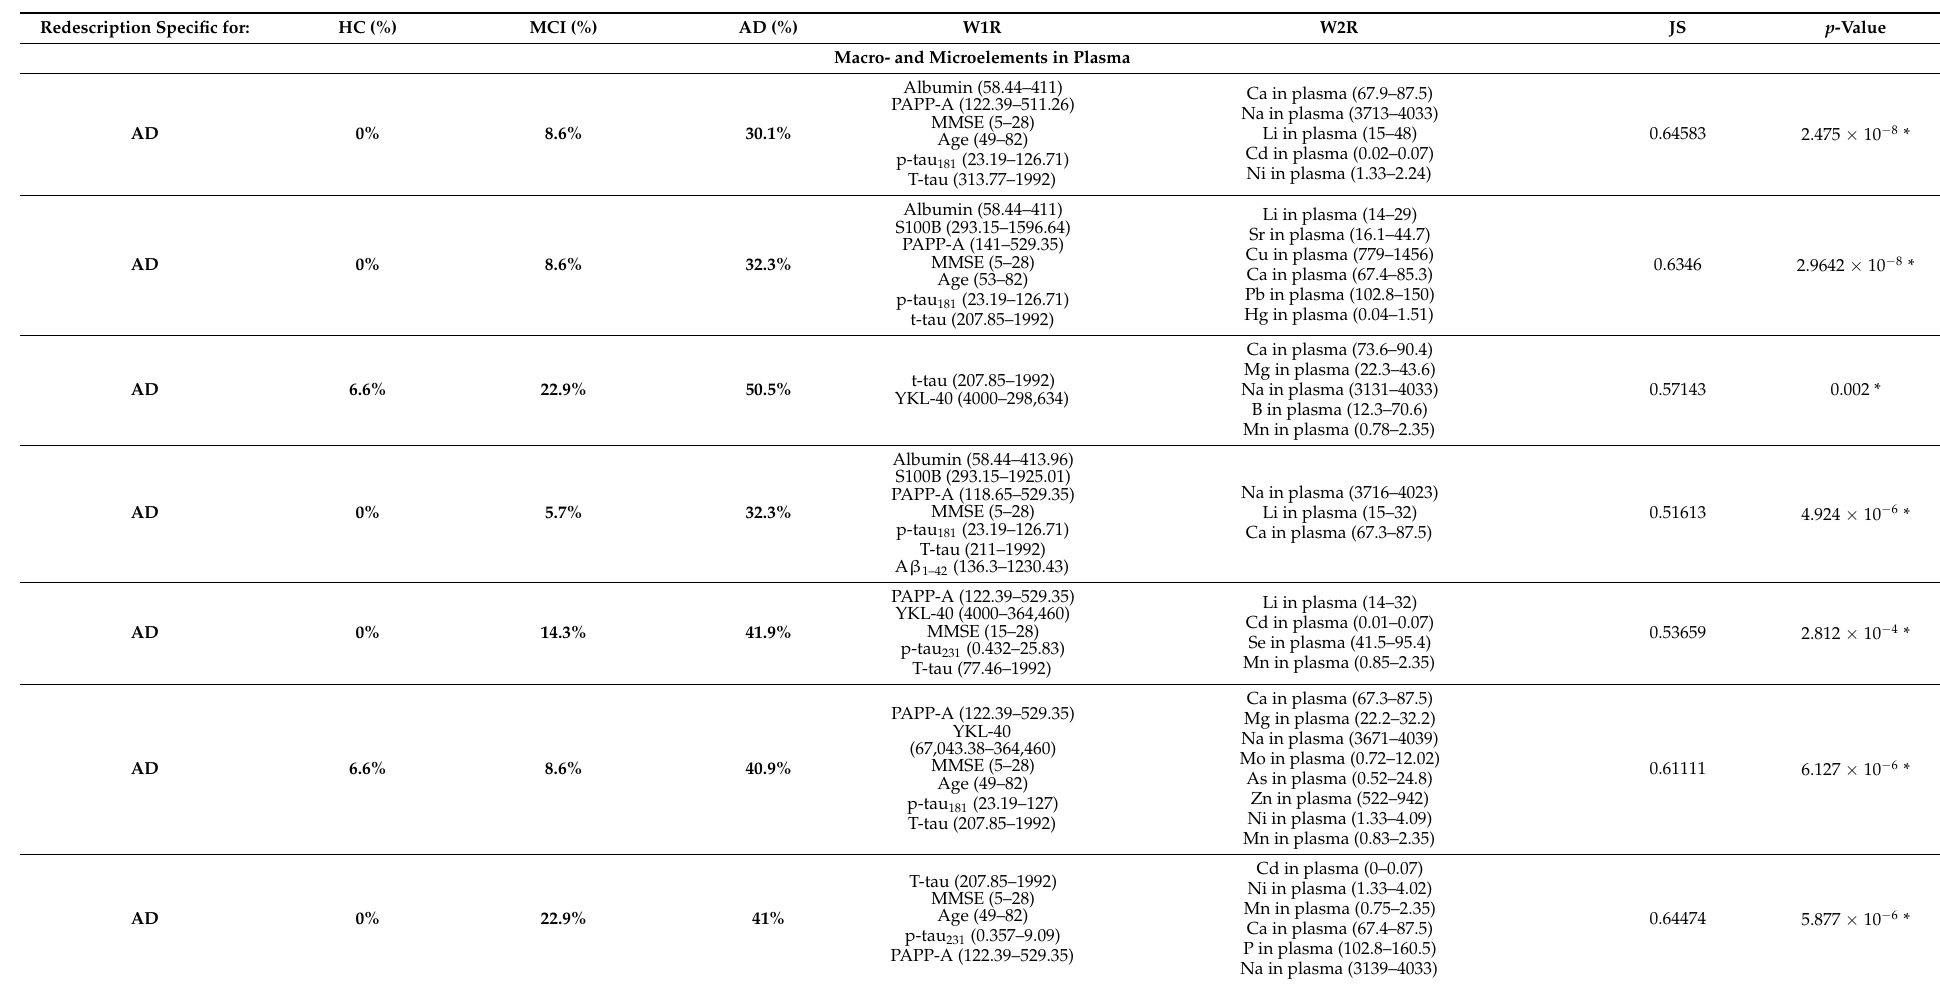
Table 7. Most significant redescriptions given by the combination of CSF AD biomarkers (first view—W1) with macro- and microelements measured in plasma (second view—W2), and macro- and microelements measured both in CSF and in plasma (second view—W2 and third view